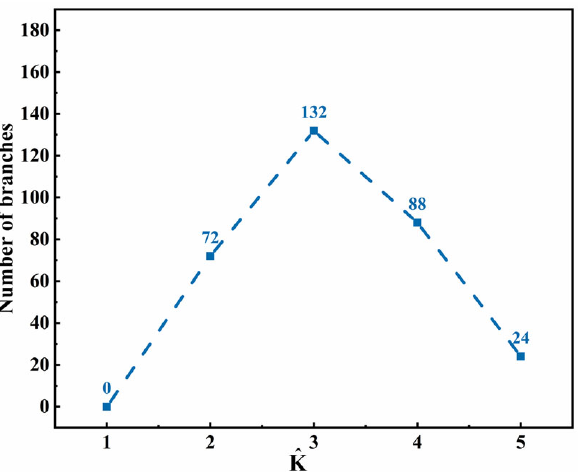
Figure 3. The relationship between the number of branches of a PTFE crystal and latent heat (anisotropic mode j = 6, evolution of time τ = 160).